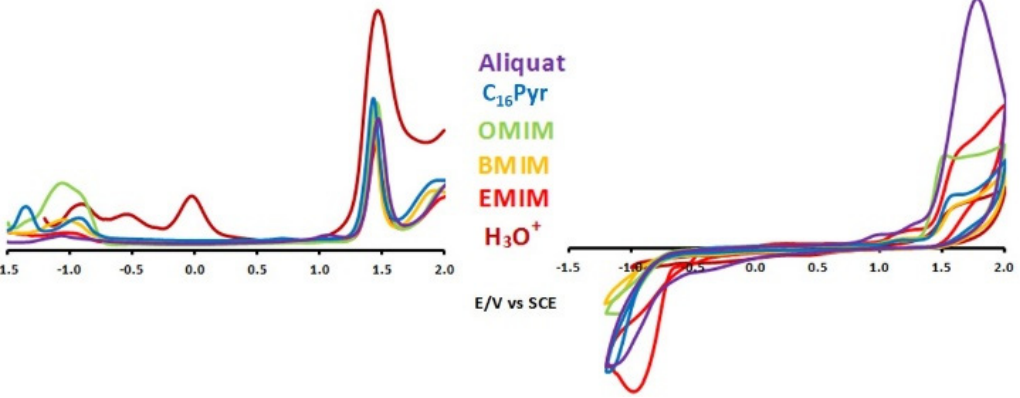
Figure 1. Voltammograms of the [Cat][MoO(O 2 ) 2 (pic)] compounds with [Cat] + = [H 3 O] + , [EMIM] + , [BMIM] + , [OMIM] + , [C 16 Py] + or [Aliquat] + : on the left voltammograms by DPV; on the right voltammograms by CV.